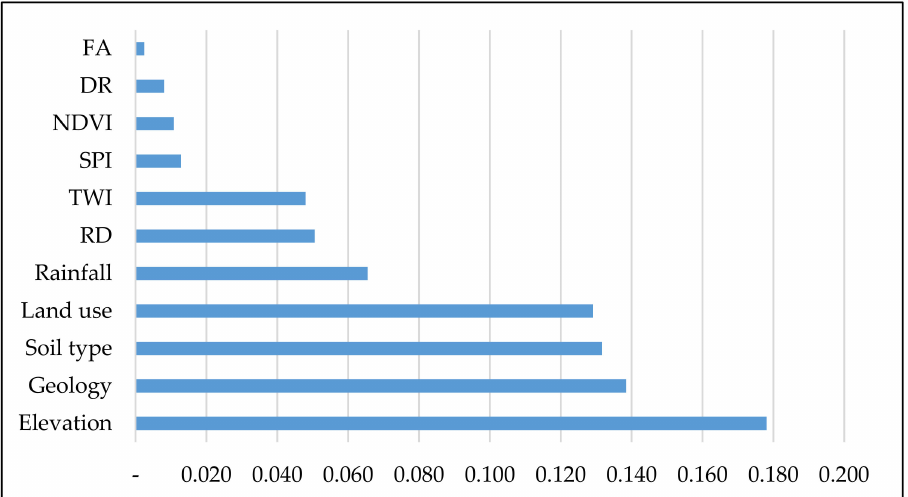
Figure 6. The rank of attribute information gain ratio.